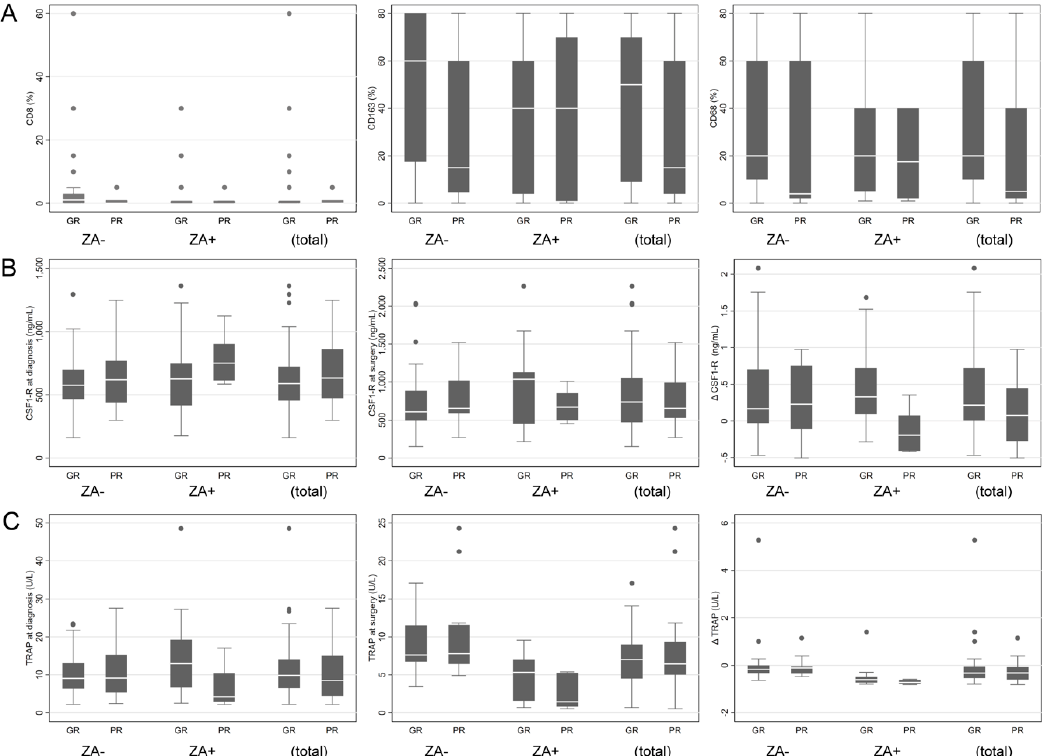
Figure 3. Correlation of biomarkers with response to chemotherapy for patients who received (ZA+) or not (ZA − ) zoledronic acid. ( A ) Representation of response to chemotherapy (GR: good responders; PR: poor responders) in relation to immunohistochemical analysis (% of cells positive) of CD8 ( left panel ), CD163 ( middle panel ) and CD68 ( right panel ). ( B ) Representation of response to chemotherapy (GR: good responders; PR: poor responders) in relation to serum analysis of CSFR-1 at diagnosis ( left panel ), surgery ( middle panel ) and the difference of CSF-1R levels between diagnosis and surgery ( right panel ). ( C ) Representation of response to chemotherapy (GR: good responders; PR: poor responders) in relation to serum analysis of TRAP at diagnosis ( left panel ), surgery ( middle panel ) and the difference of TRAP levels between diagnosis and surgery ( right panel